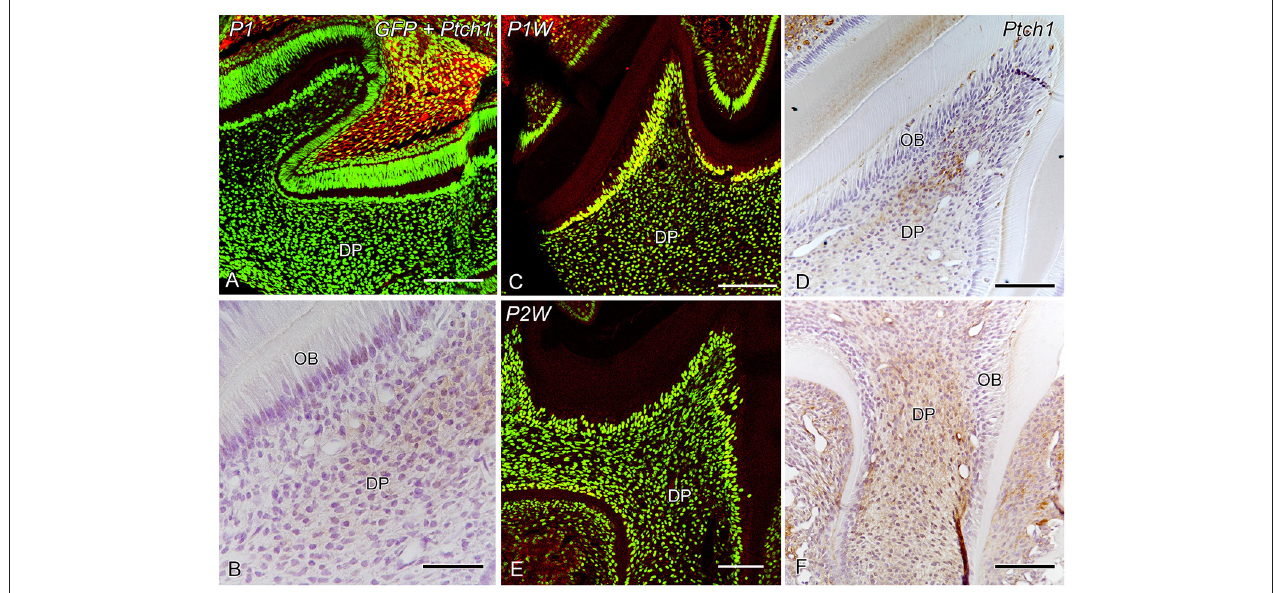
FIGURE 3 | GFP expression and Ptch1 IR (A,C,E) and Ptch1 IR (B,D,F) in the developing molars at P1 (A,B) , P1W (C,D) , and P2W (E,F) ( DP dental pulp, OB odontoblasts). (A–F) Intense Ptch1 + cells are located in the enamel organ and dental pulp. (B) Higher magnification of the boxed area in (A) . Scale bars: 100 µ m (A,C,D,E,F) and 50 µ m (B)